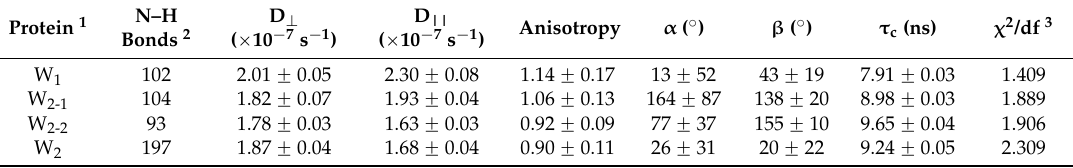
Table 1. Rotational diffusion tensor parameters that best fit indicated 15 N spin relaxation data set. Protein